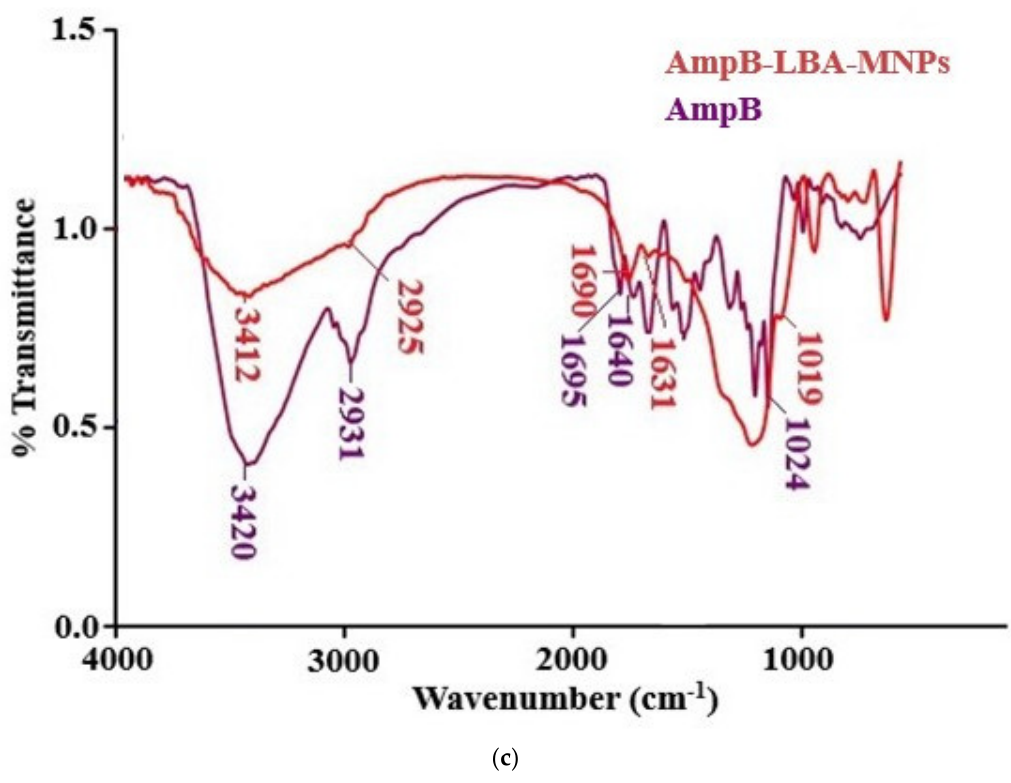
Figure 2. ( a ) FTIR spectra of APT-MNPs, LBA, and surface-functionalized LBA-MNPs; ( b ) FTIR spectra of CUR and CUR-LBA-MNPs; ( c ) FTIR spectra of AmpB and AmpB-LBA-MNPs.